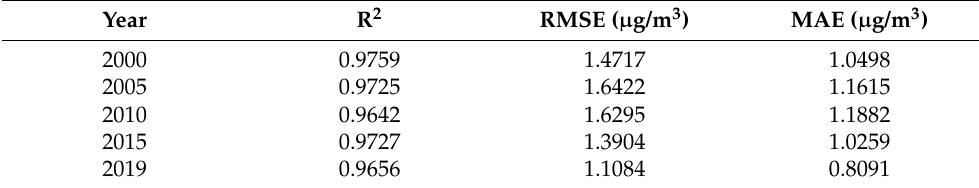
Table 2. Results of the 10-fold cross-validation evaluation indices in five periods.